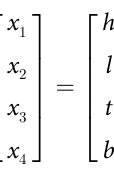
), beam end deflection c